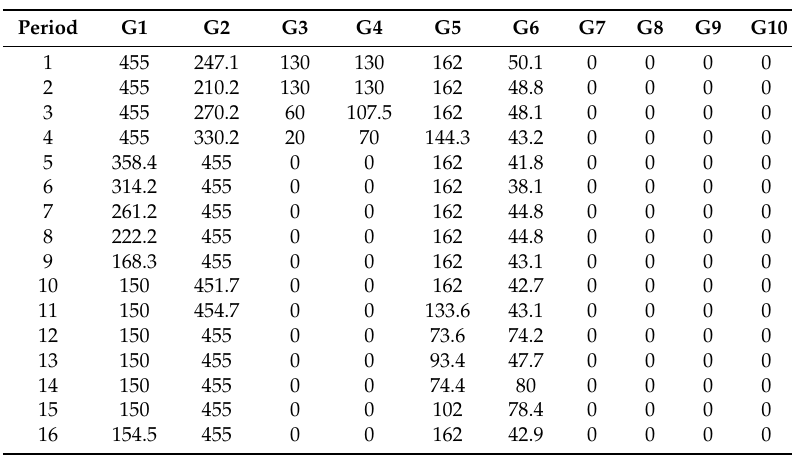
Table A5. Executed rolling plans for Case